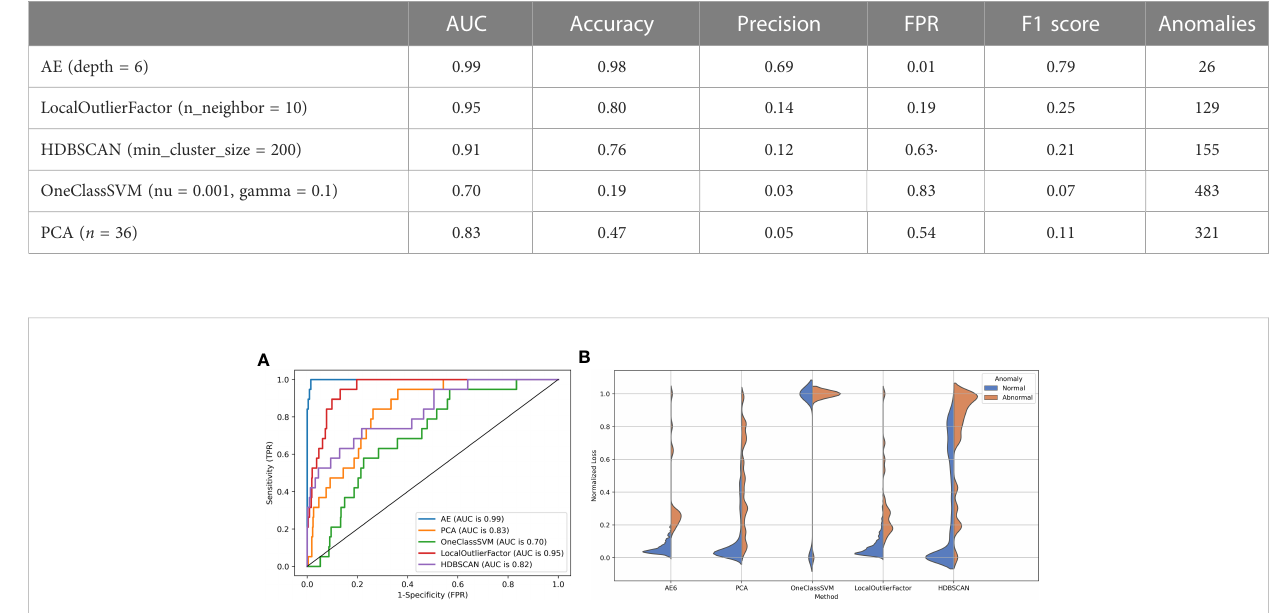
TABLE 3 Comparison of the four baseline detection